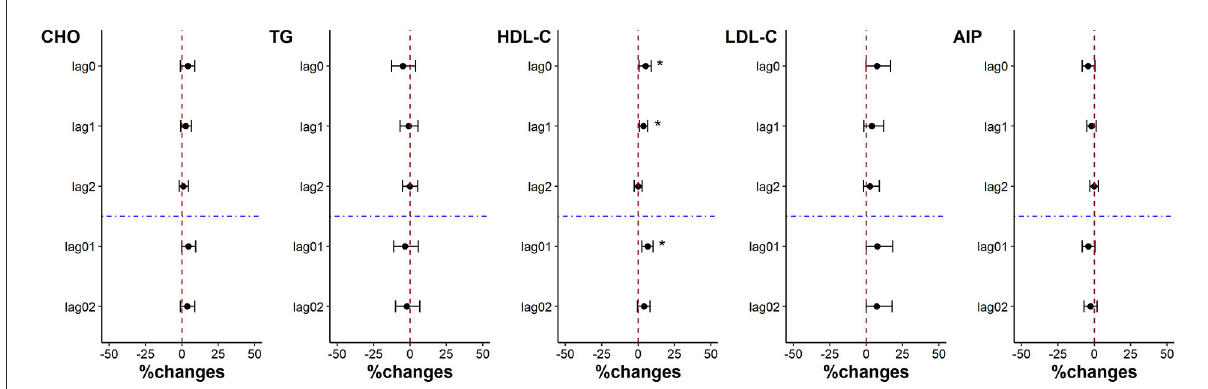
FIGURE5 Percent changes in blood lipid indicators associated with an IQR decrease in PM 2.5 exposure. * p <